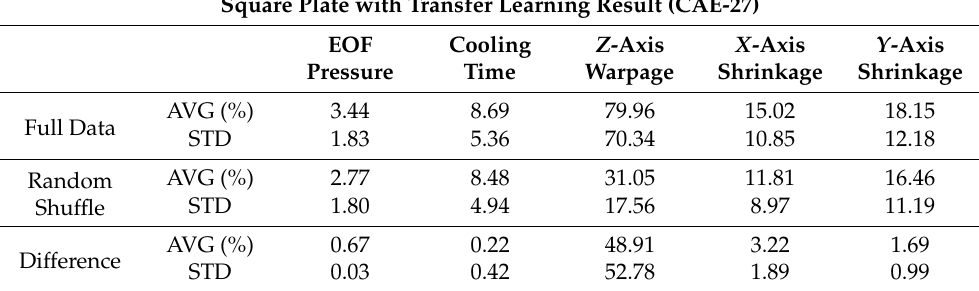
Table 9. Transfer learning results for the square flat model